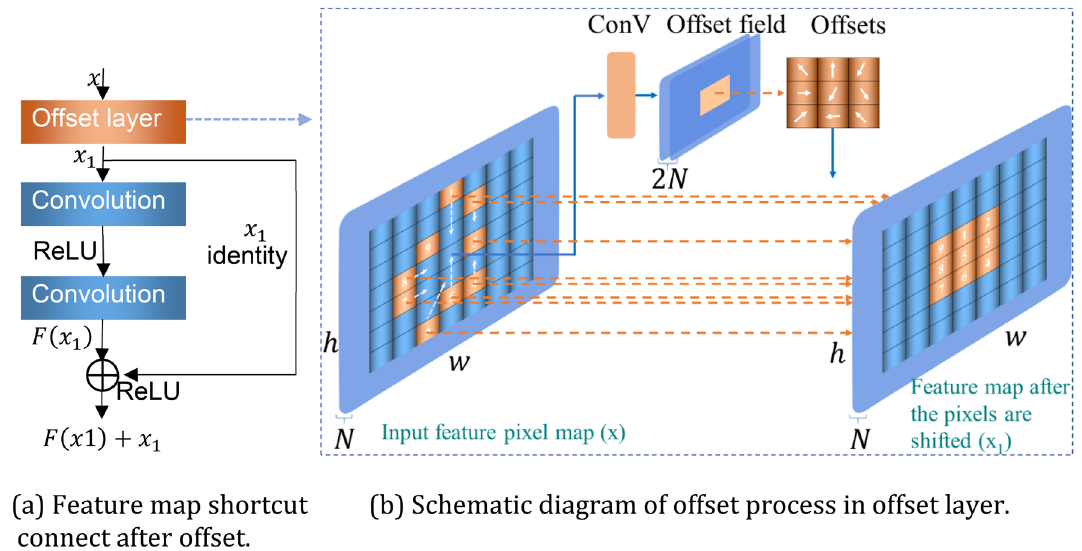
Figure 6. Diagram of structure of